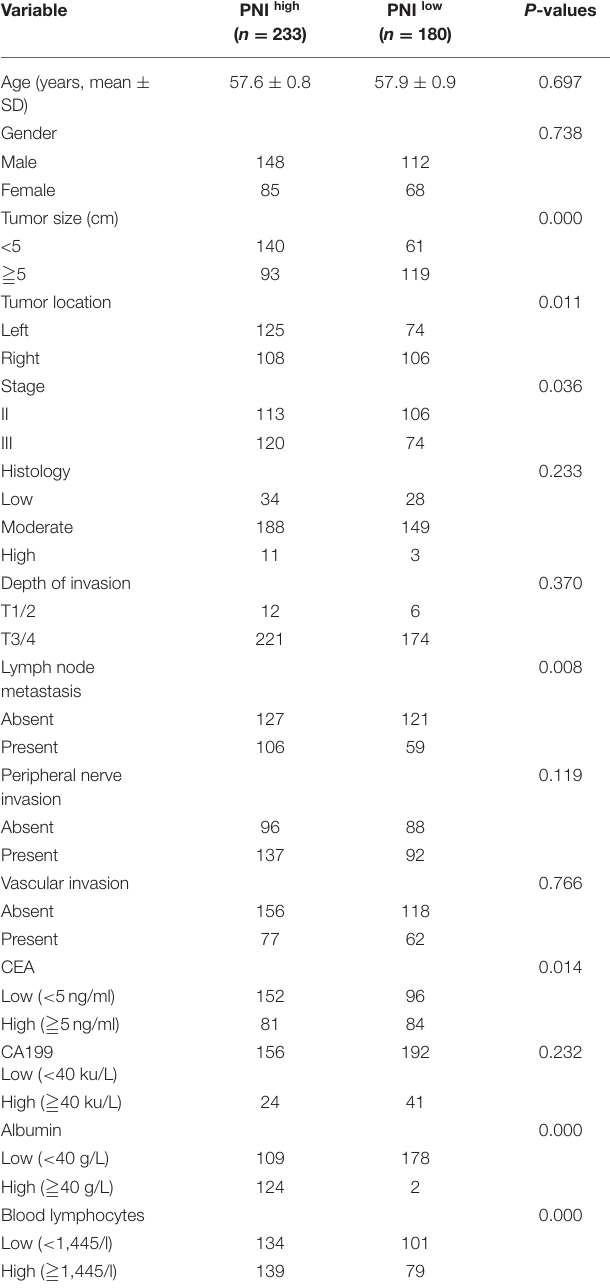
TABLE 1 | Relationships between preoperative prognostic nutritional index (PNI) and clinicopathological variables in leaning set with stage II–III colon cancer.